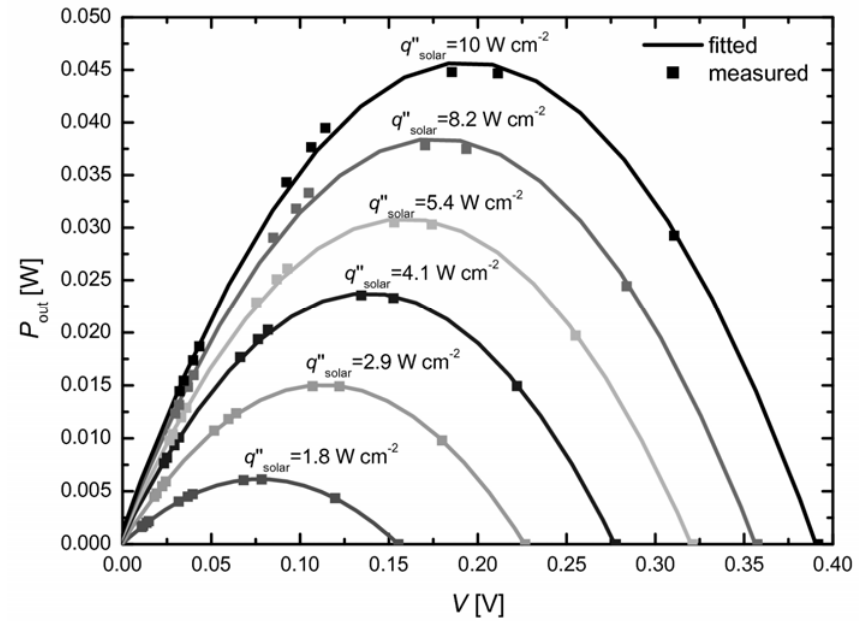
Figure 4. Fitted and measured voltage-power curves for incident solar radiative fluxes in " q = 1.8 – 10 W cm -2 , and for external loads with resistance in the range the range solar R = 0.1-3.5 Ω for module with l = 4 load